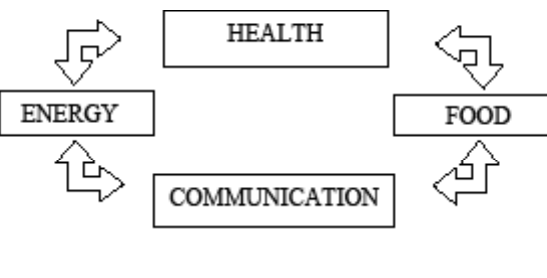
Figure 1: Global Capitalism. Basic